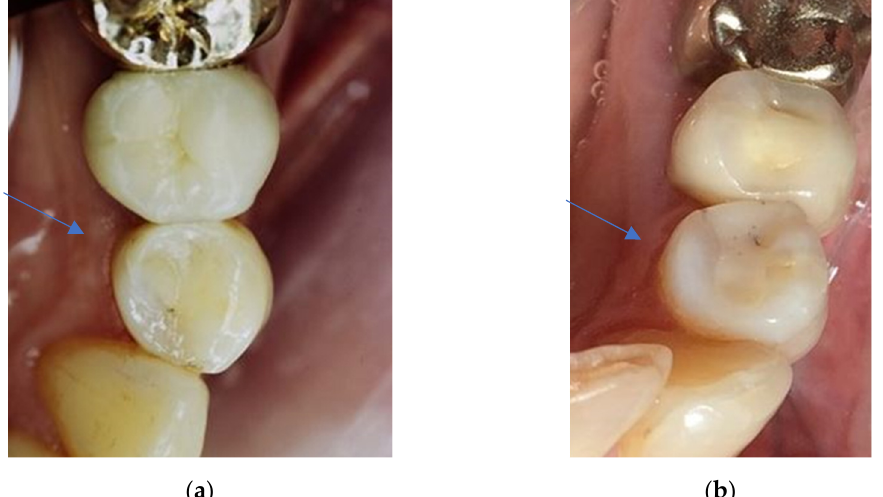
Figure 6. ( a ) Clinical view of a Herculite XRV restoration at first examination (34 od). Aesthetic anatomical form, approximal anatomical form, tooth integrity, and retention were grade 1 (clinically excellent/very good). Marginal adaptation, occlusal contour/wear, and surface luster were grade 2 (clinically good). ( b ) Clinical view of the Herculite XRV restoration displayed in Figure 6a after 24 years in situ. The grades of the criteria approximal anatomical form and occlusal contour/wear stayed the same, and the five other criteria were all evaluated to be of higher grades. Marginal adaptation scored the highest grade (grade 4 = clinically unsatisfactory). The biggest difference in grades between the first and the second evaluation was for the criteria marginal adaptation and retention.